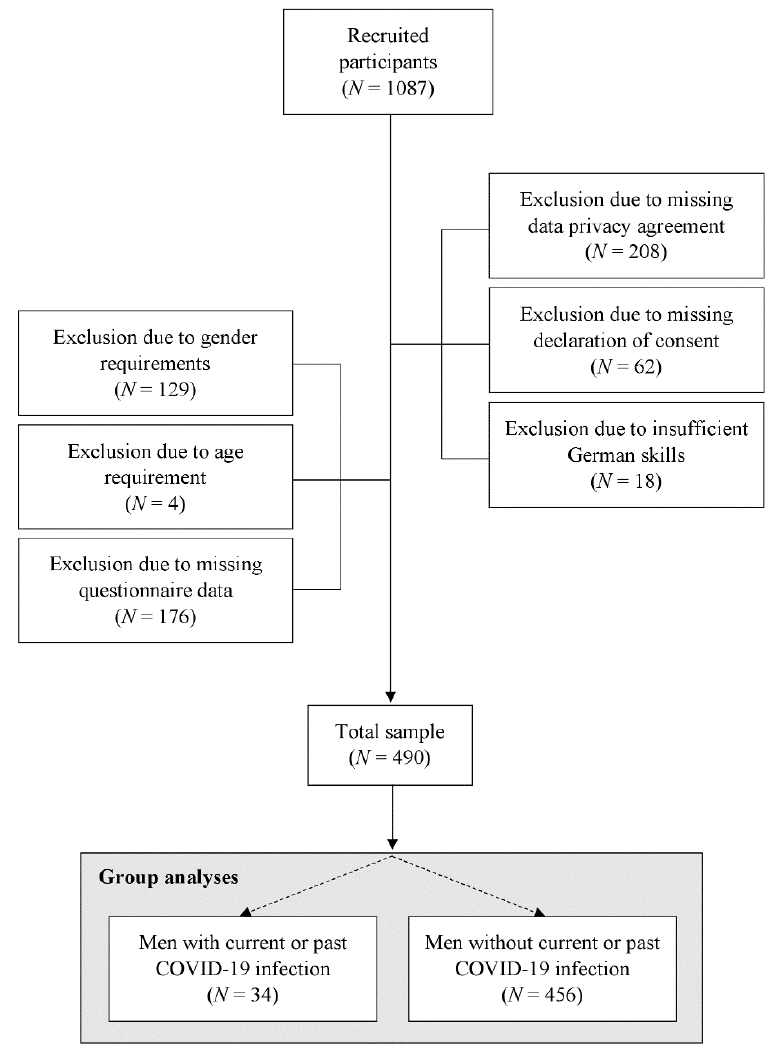
Figure 1. Flow diagram of the inclusion and exclusion process. Note: N = number of participants. Table 1. Descriptive statistics for the